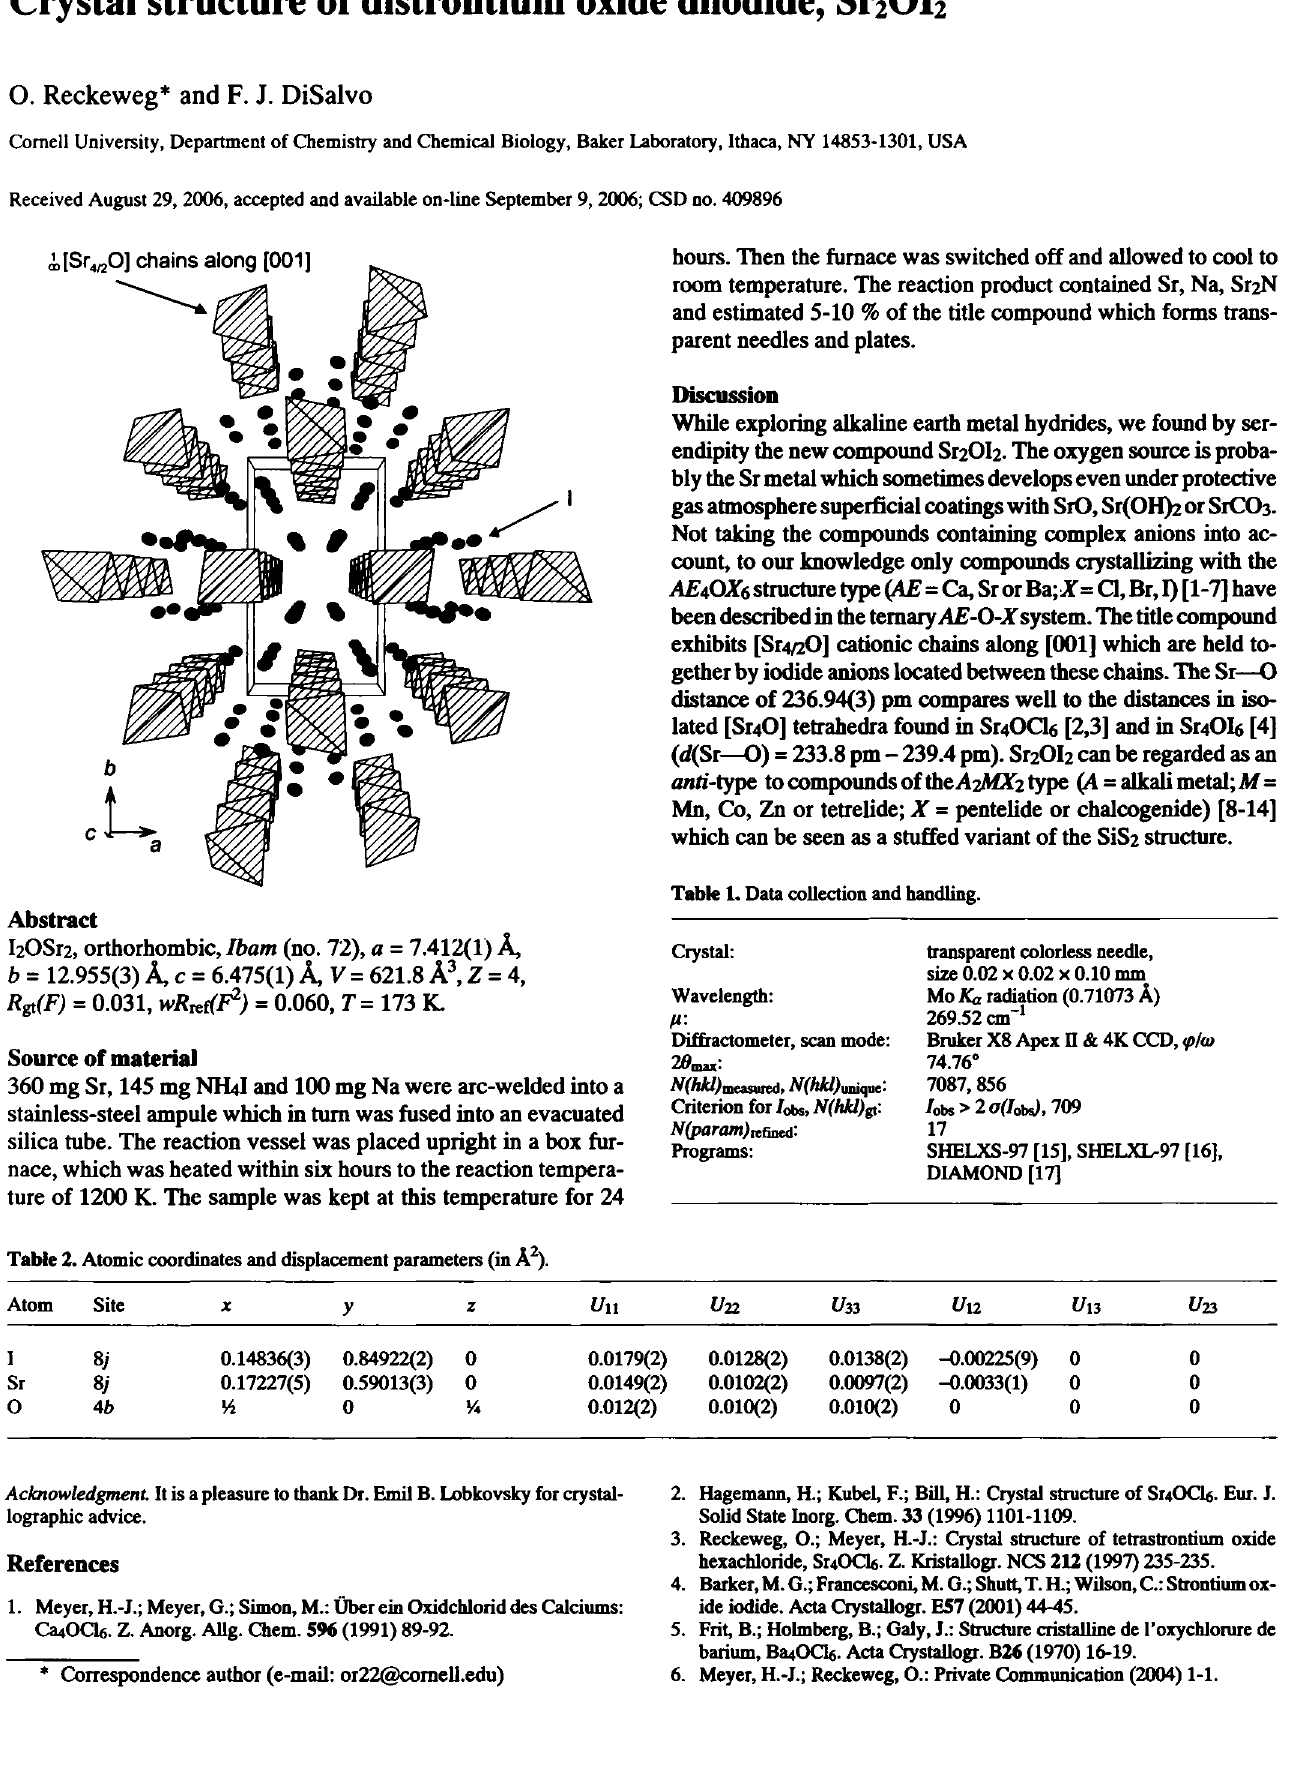
Table 2. Atomic coordinates and displacement parameters (in A 2